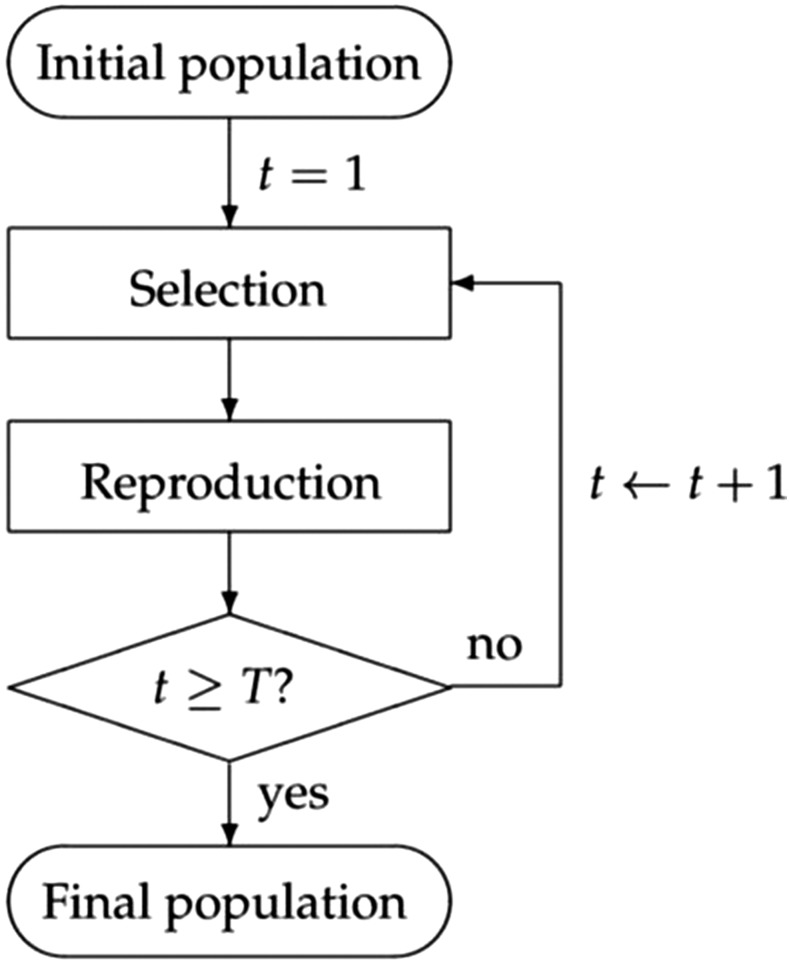
The simulation diagram, adopted from Goiffon et al. (2017).